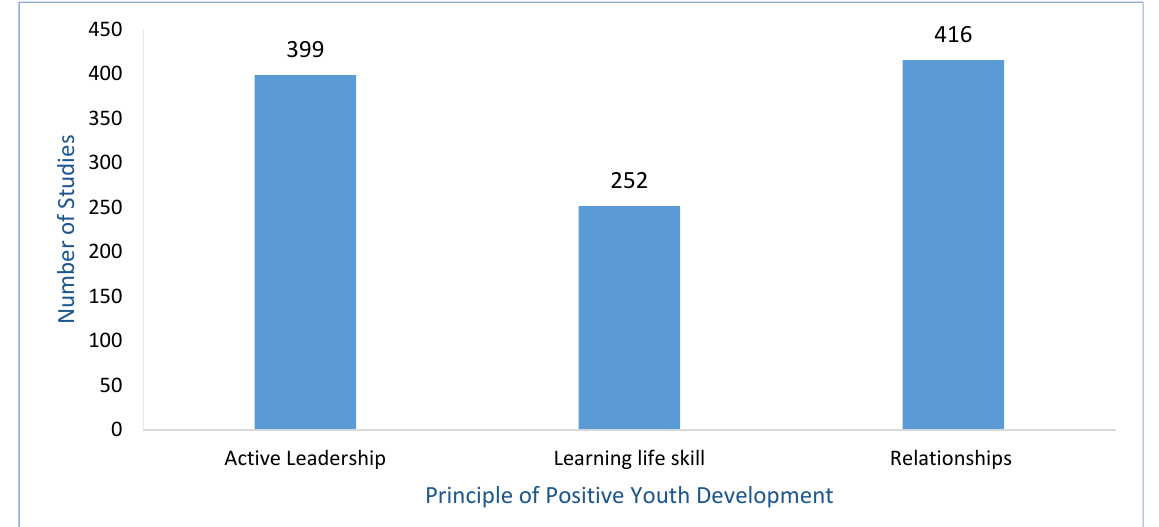
Figure 2. The Breakdown of Studies Containing Each Principle of